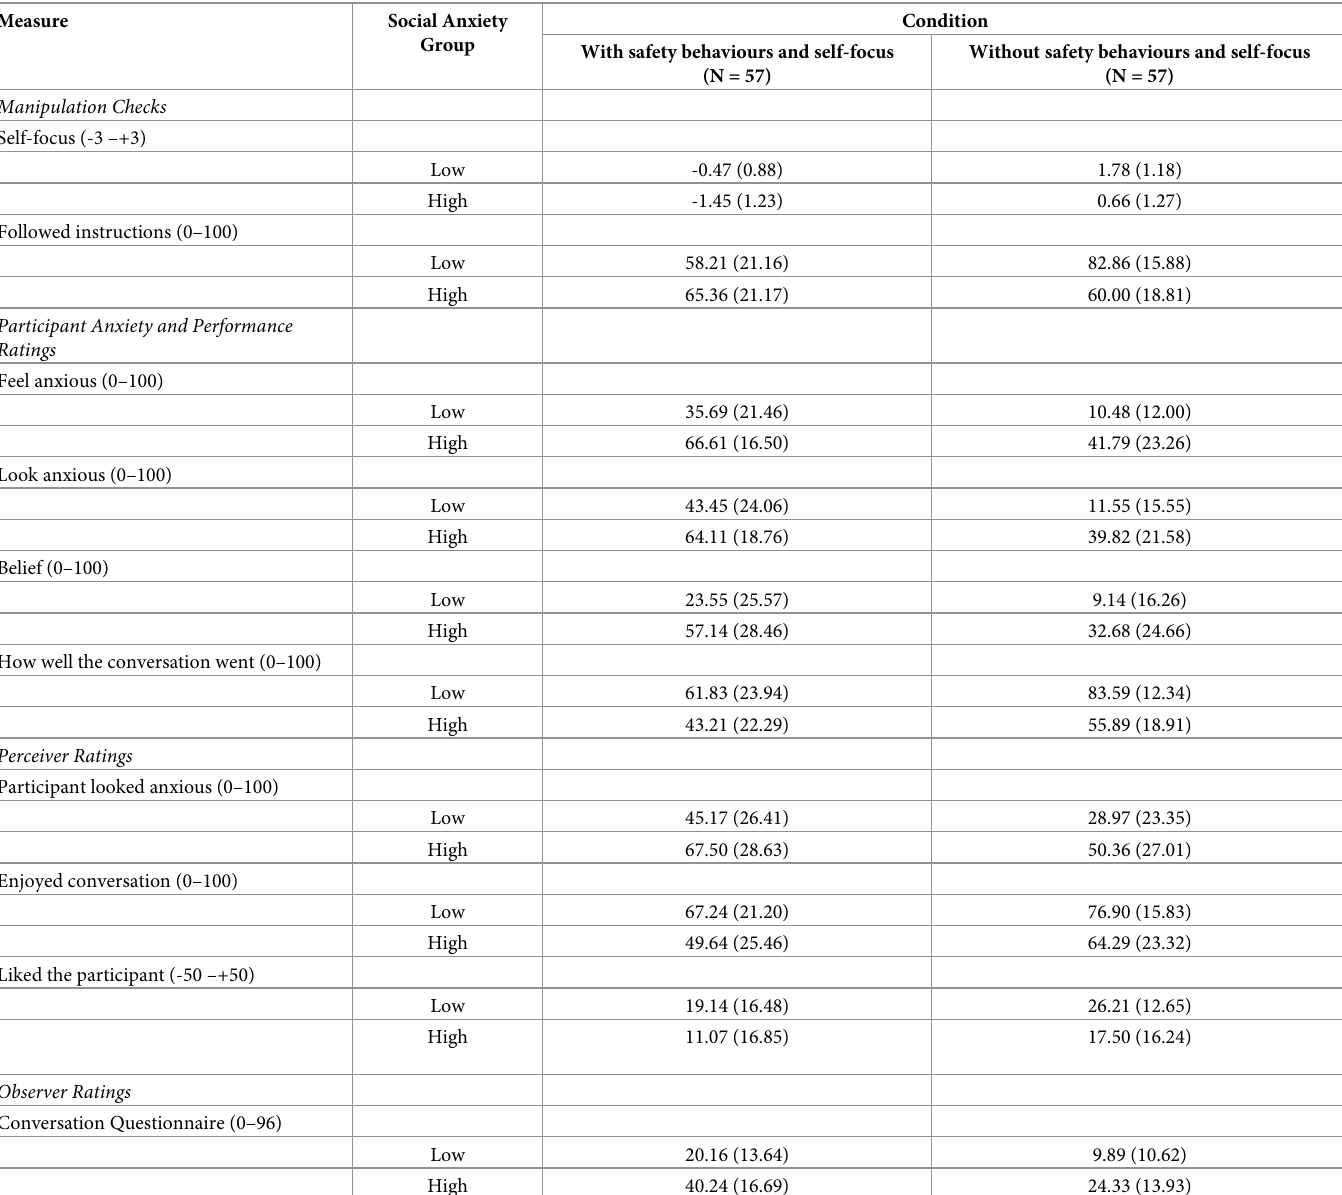
Table 2. Means and standard deviations for the high and low social anxiety groups in the ‘With’ and ‘Without’ conditions.